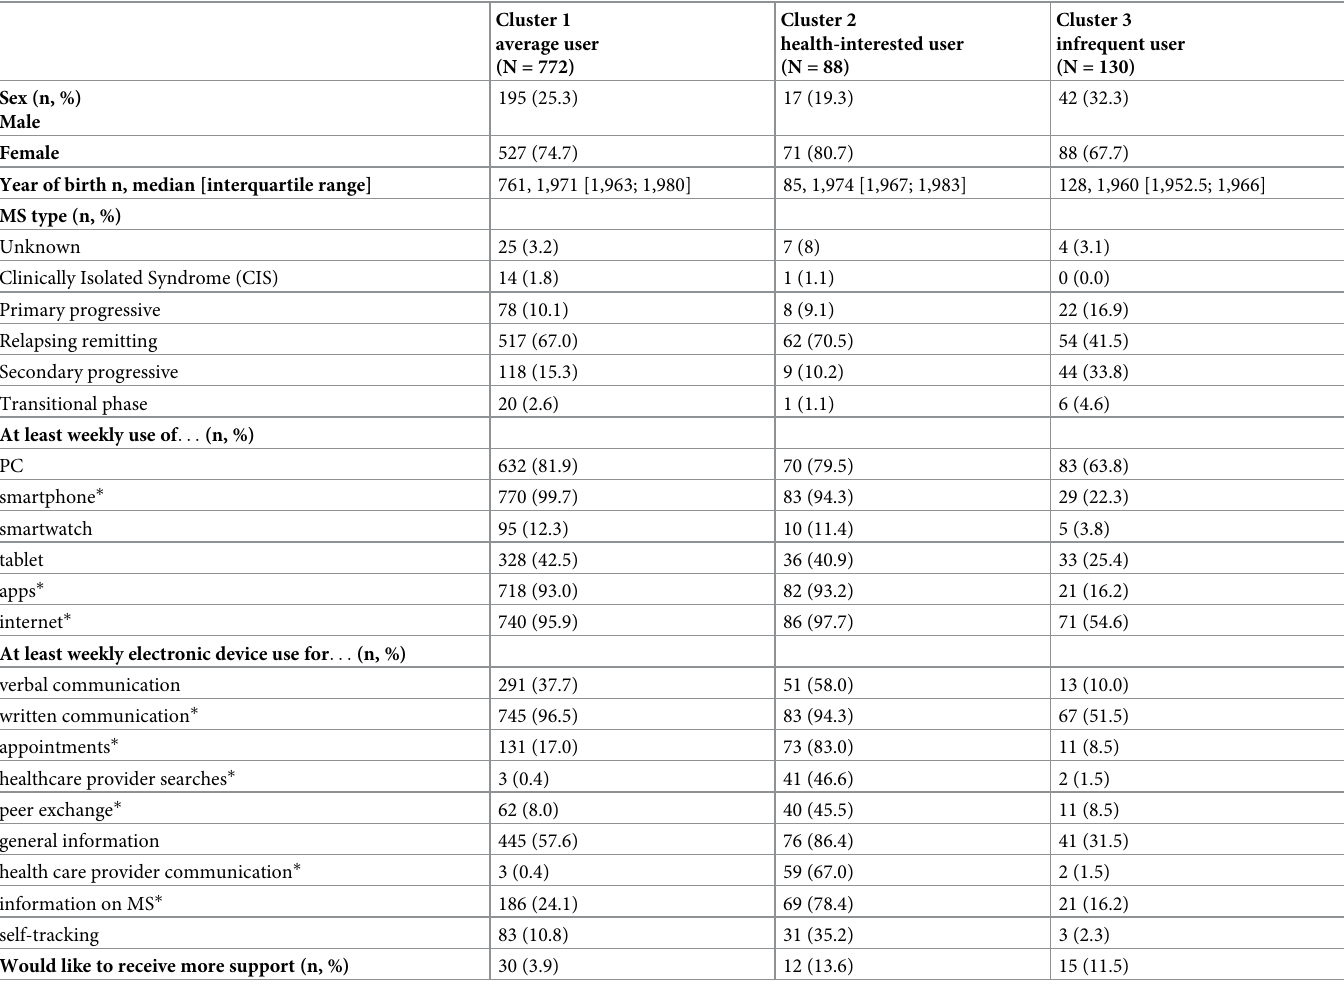
Table 1. Cluster